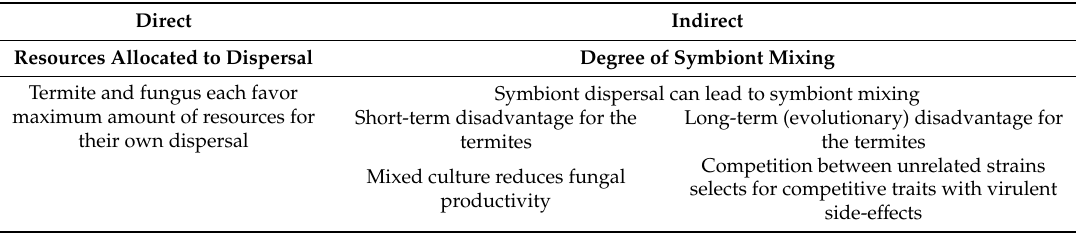
Table 1. Host- symbiont conflicts in the termite-fungus symbiosis due to horizontal transmission. Direct Indirect Resources Allocated to Dispersal Degree of Symbiont Mixing Termite and fungus each favor maximum amount of resources